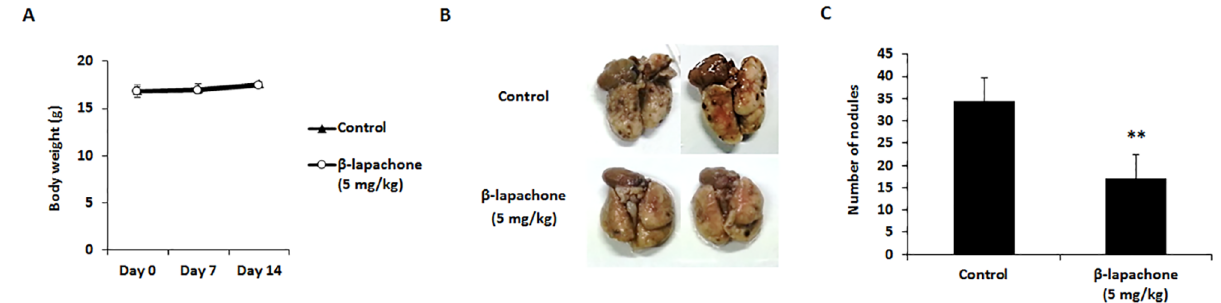
Fig 8. Effect of β -lapachone on the lung metastasisof B16F10 cells. C57BL/6mice were intravenously injectedwith B16F10cells (2 × 10 5 cells) via the tail vein. The mice were intraperitoneallyinjected with DMSO or β -lapachone(5 mg/kg) every other day until sacrifice. (A) Measurement of body weight during β -lapachoneadministration. (B) Lungswere excised and fixed with 3.7% formaldehyde to count and compare the patterns of pulmonary tumor noduleformation among the experimental groups. (C) The numberof tumor nodulesis expressed as the mean ± SD. Values are the means ± SD of data from three independentexperiments. ** P <